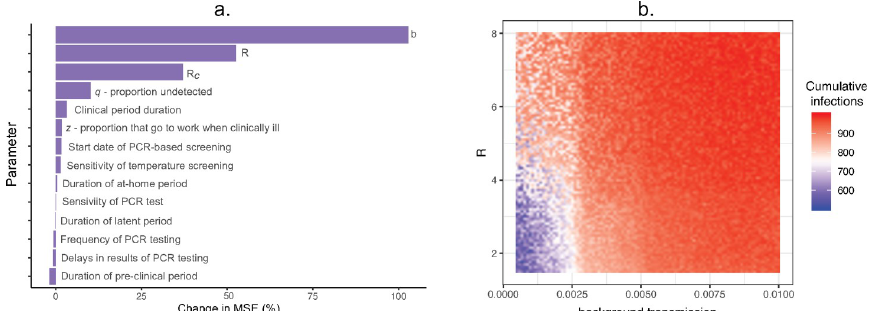
Fig 5. Sensitivity analysis. a) Variable importance plot for random forest sensitivity analysis, with most important parameters ranked from highest to lowest in terms of their association with the predicted number of cases. Percent change in MSE was calculated as the percent change in mean squared error when the explanatory variable was permuted relative to the outcome. b) Predicted cumulative infections from the random forest sensitivity analysis based on the interaction between R and background transmission rate. Shading represents the predicted cumulative number of infections for a given value of R and b (background transmission).